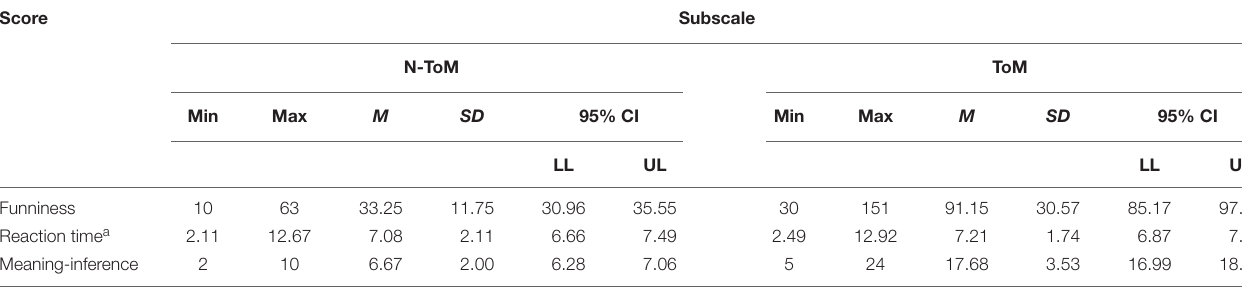
TABLE 2 | Descriptives of test scores and reaction times for main study group. Score Subscale